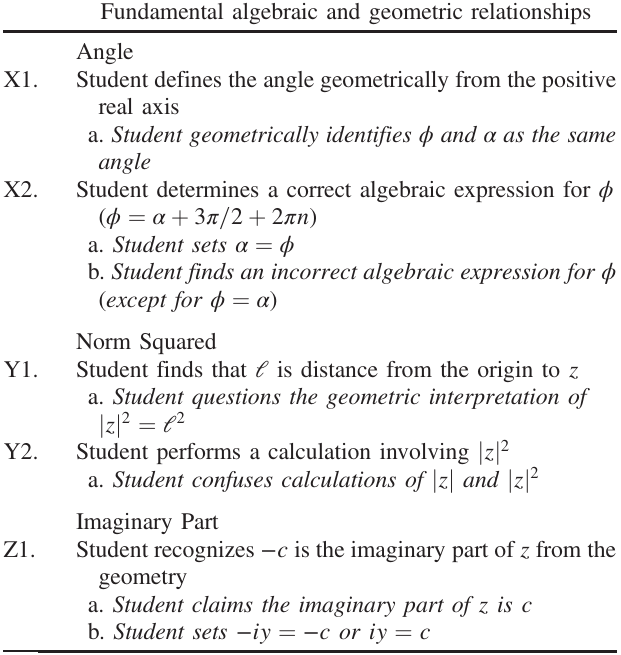
TABLE II. Summary of codes for translations of geometry